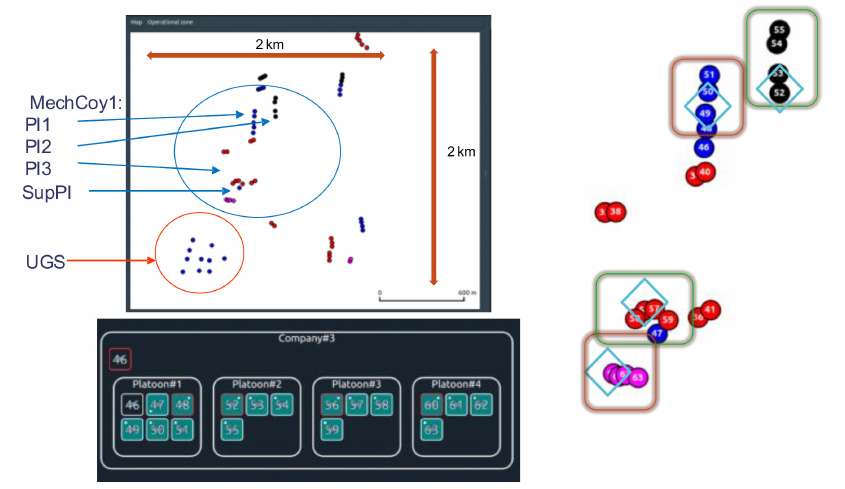
Figure 14. The communications network for UHF sessions (Comp_BMS) for the MBv5 best case.